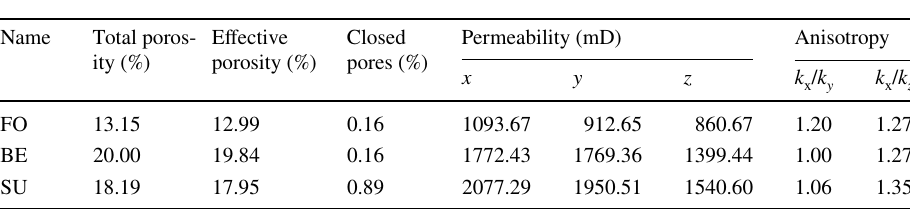
Table 1 Porosity and permeability of the samples